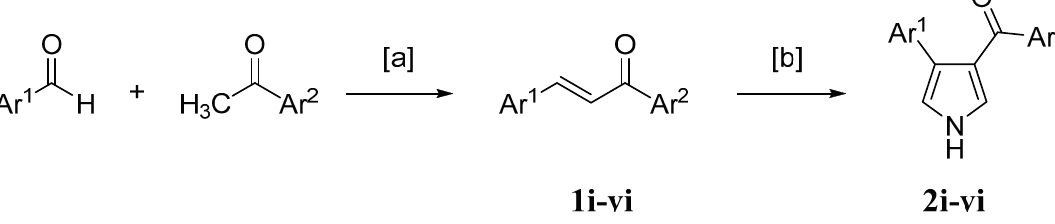
Scheme 1. Derivatives via a van Leusen